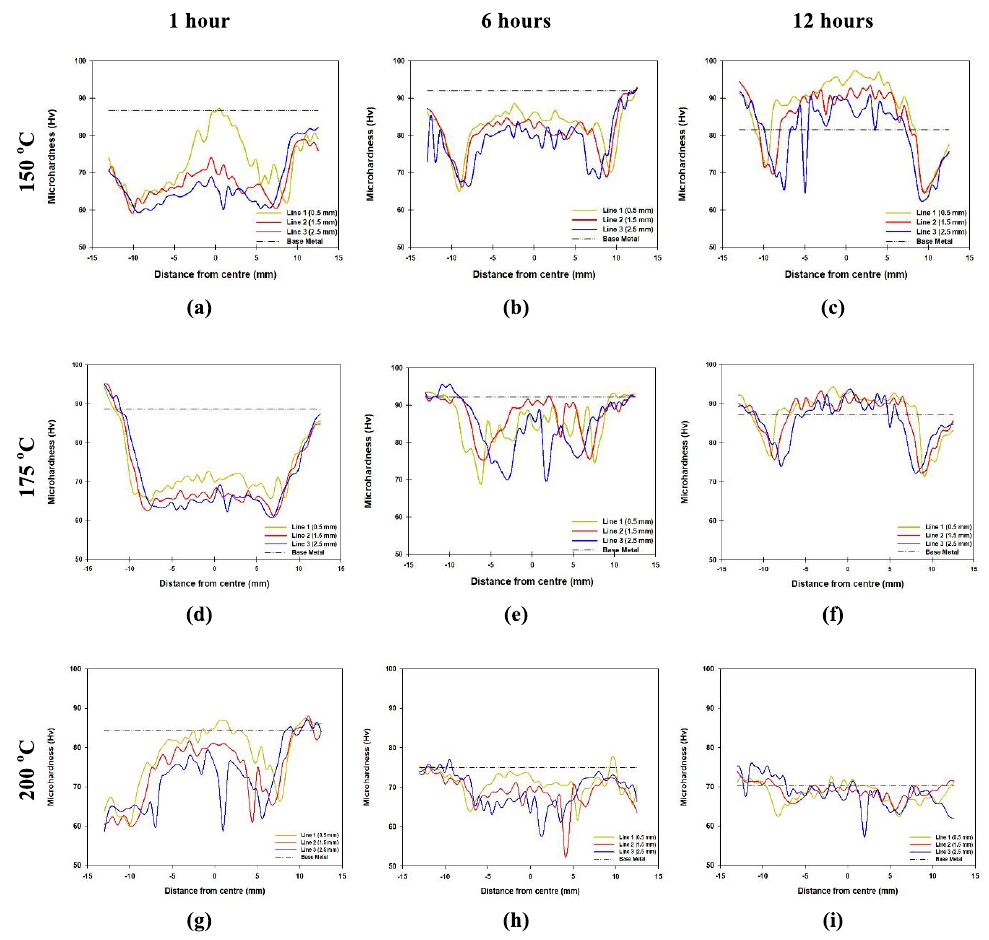
Figure 14. Vickers microhardness profiles of FSP samples aged at: ( a – c ) 150 °C; ( d – f ) 175 °C and ( g – i ) 200 °C.